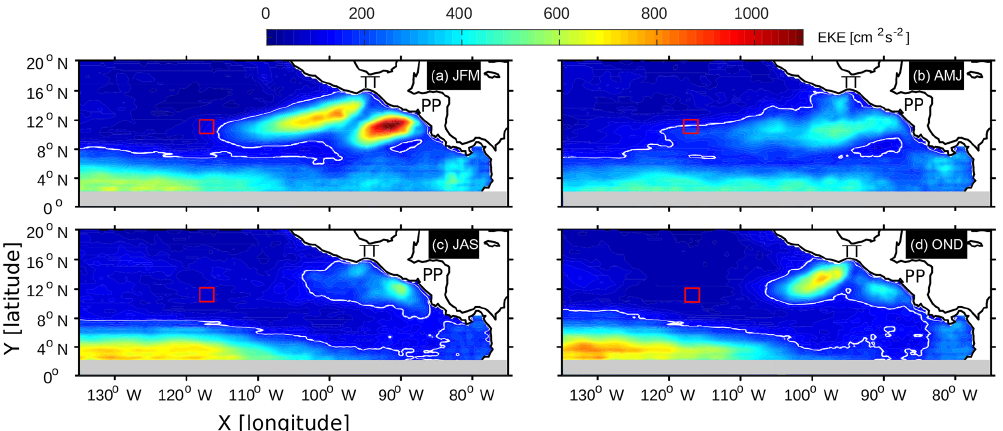
Figure 1. Spatial distribution of seasonal mean eddy kinetic energy (EKE) over a period from 1993 to 2016 obtained from AVISO satellite altimetry data for (a) January–February–March, (b) April–May–June, (c) July–August–September, and (d) October–November–December. The solid white contours represent an EKE of 150cm 2 s − 2 , which is assumed as a threshold for highly energetic regions. The red square indicates the location of the study region (abbreviated as SR in the text).